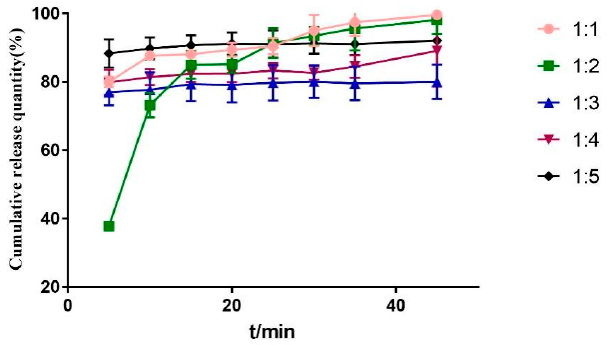
Figure 7. DSC diagram of solid dispersion prepared by different mass ratio.